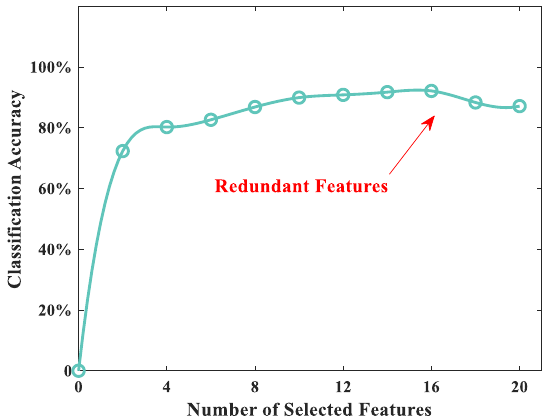
Figure 3. Classification accuracy results with different numbers of selected features. Training result by SVM model. Each result is based on 100 independently repeated trials.